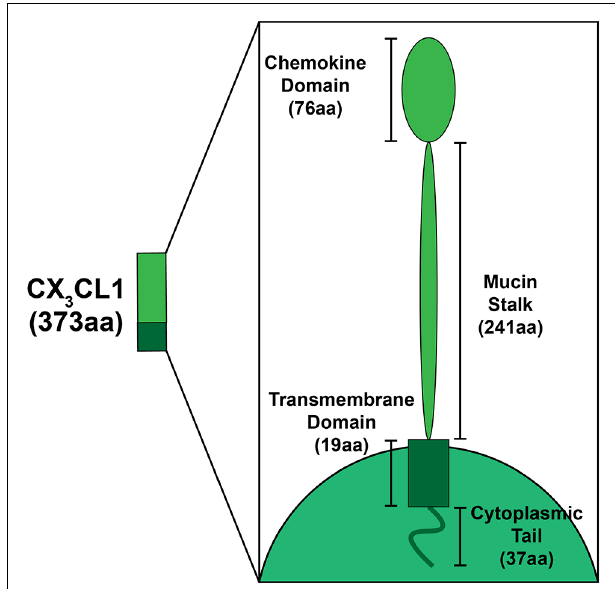
FIGURE 1 | Schematic depicting the structural components of fractalkine (FKN; CX 3 CL1). FKN is a large (373aa) transmembrane protein found exclusively on neurons in the central nervous system (CNS)/peripheral nervous system (PNS), and on SGNs and inner hair cells in the cochlea. Structural components that form FKN include the extracellular chemokine domain (76aa), extracellular mucin stalk (241aa), the transmembrane domain (19aa), and the intracellular cytoplasmic tail (37aa).